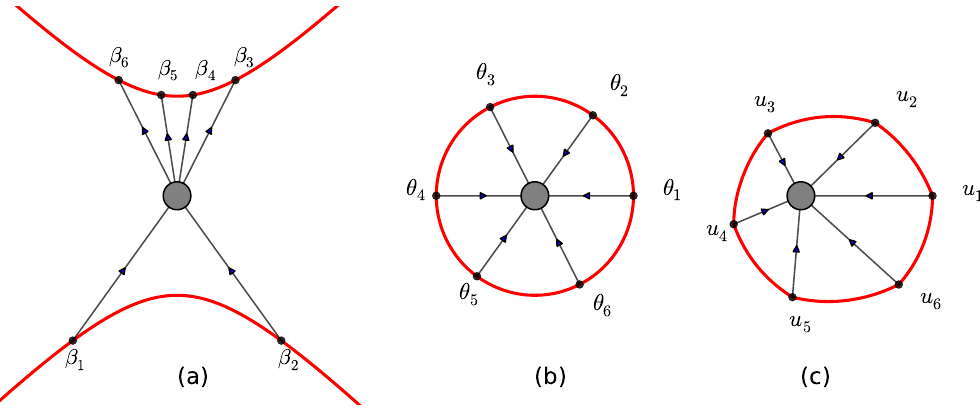
Figure 3 . (a) Scattering process in the Lorentzian space with LSZ surfaces taken to be hyperbolas, the particles intersect the surfaces at hyperbolic angles determined by their rapidities. (b) The same process but rotated to the Euclidean space. Positions of the particles on the boundary circle are determined by their Euclidean rapidities (cid:18) i = (cid:22) (cid:12) i + (cid:25) . (c) Coupling to JT gravity results into the deformation of the boundary surface. Positions on the boundary are given by u i = (cid:22) (cid:12) i + (cid:25) . The grey bulb on all three (cid:12)gures represents the interaction region M int